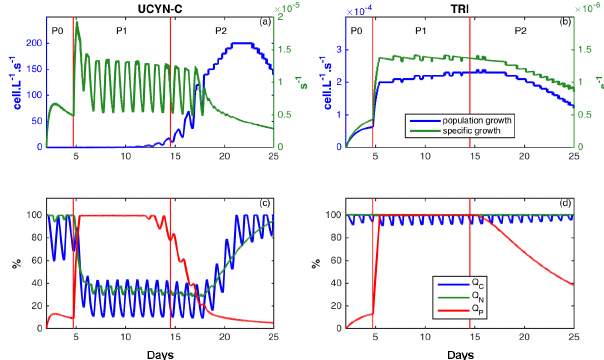
Figure 6. Patterns of change over time in specific (green) and population (blue) growth rates function of (a) unicellular N 2 - fixing cyanobacteria (UCYN-C, cells − 1 ) and (b) Trichodesmium (TRI, trichome s − 1 ) and carbon (C, blue), nitrogen (N, green) and phosphorus (P, red) relative intracellular quota in (c) unicel- lular N 2 -fixing cyanobacteria (Group C; UCYN-C, %) and (d) Tri- chodesmium (TRI, %) in model outputs in SIM E . Red vertical lines distinguish the three periods P0 (before the DIP enrichment), P1 (diatom–diazotroph associations dominate the diazotrophic com- munity) and P2 (unicellular N 2 -fixing cyanobacteria (Group C) dominate the diazotrophic